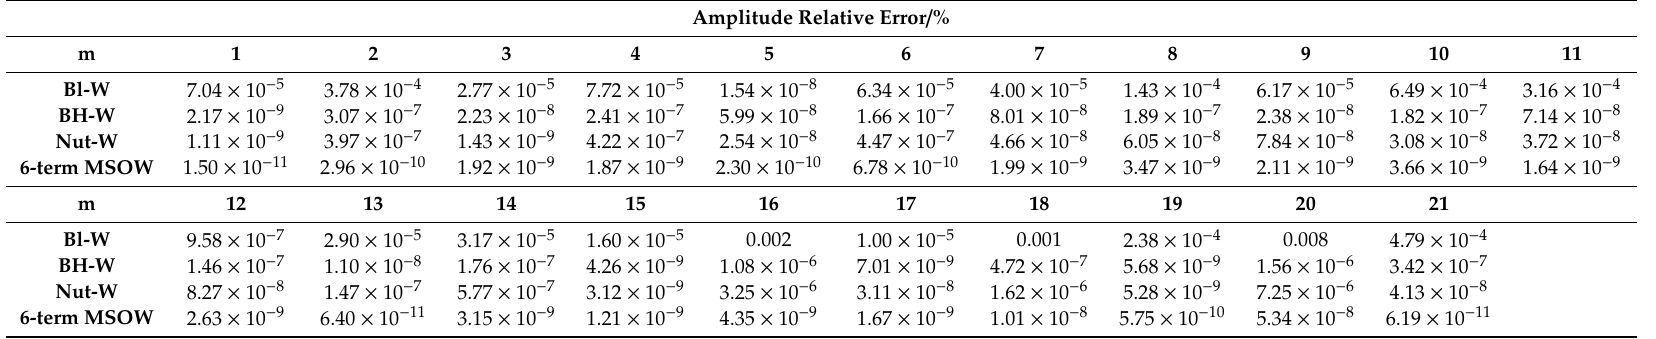
Table 5. Harmonic detection error of amplitude parameter with high-order and weak-amplitude component.